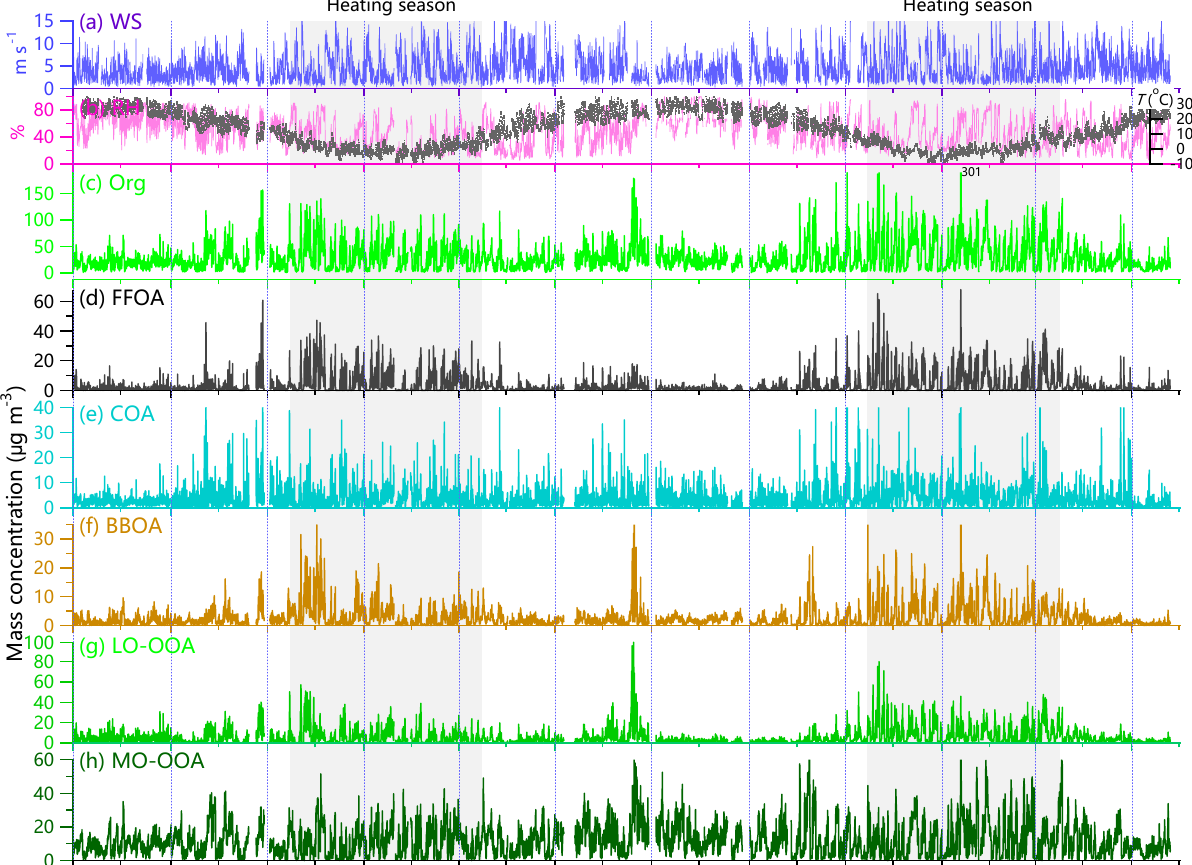
Figure 2. Time series of meteorological parameters (a) WS and (b) RH and T and hourly average mass concentrations of (c) organics (Org), and (d–h) five OA factors, i.e., FFOA, COA, BBOA, LO-OOA, and MO-OOA. The period of heating season (15 November–15 March) is also marked as shaded areas.